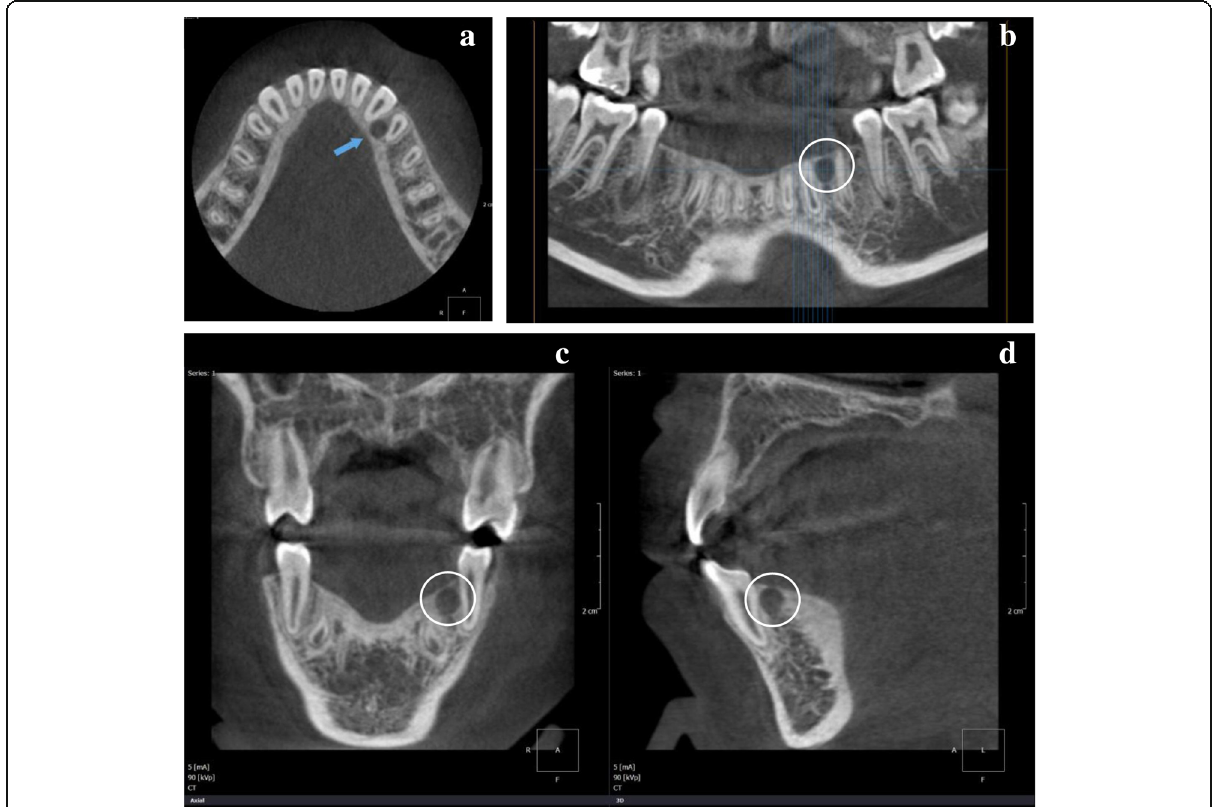
Fig. 1 Radiographic findings of POT. a Cone-beam CT showing a round cavity with defined cortical border that is mesiolingual to the root of tooth 34. b-d Panoramic radiograph demonstrates well-defined radiolucency (circled area) in the mandibular left